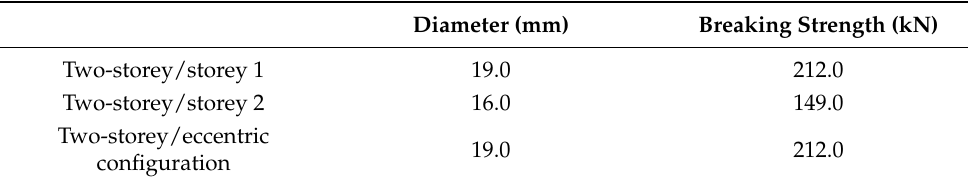
Table 2. Diameter and breaking strength of